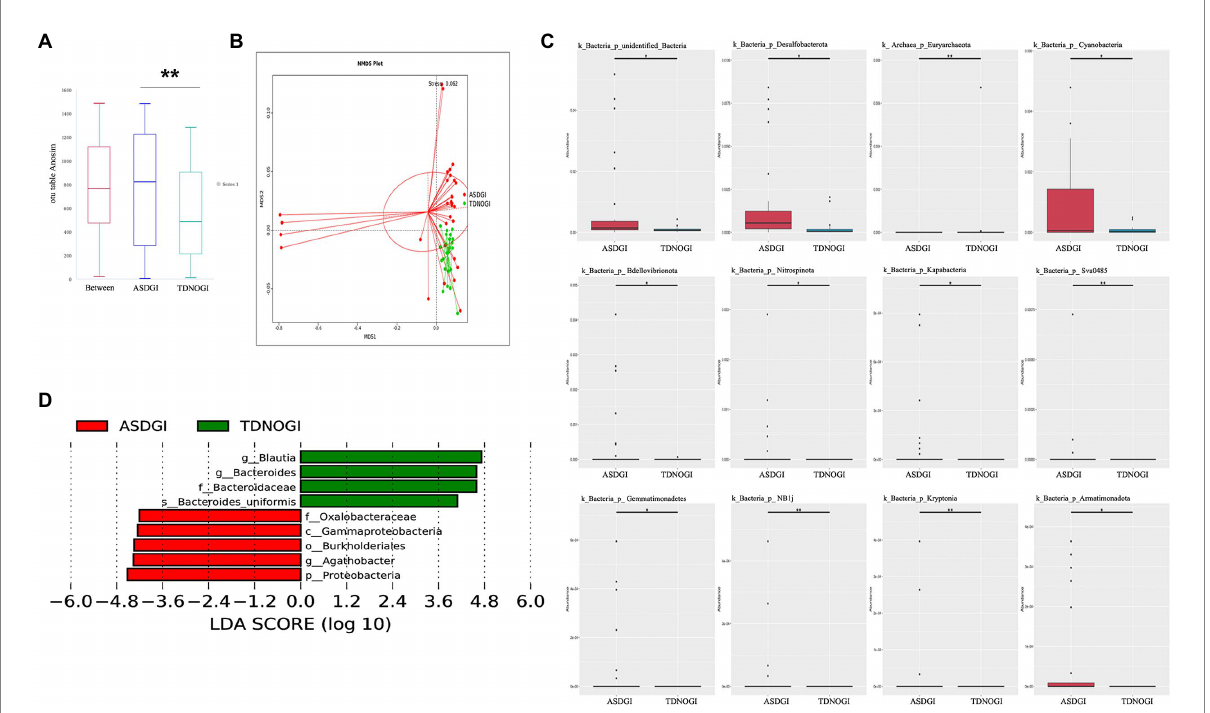
FIGURE 5 The shape of the microbiota with and without GI symptoms. (A) ANOSIM was used to compare within- and between-group similarities ( p = 0.005). (B) Non-metric multidimensional scaling (NMDS) reflected the dramatic variation between the two groups (stress = 0.062). (C) The top 12 relative abundances of the most differentially abundant gut bacterial phyla between ASDGI and TDNOGI. (D) Distribution histogram of phylum level based on linear discriminant analysis (LDA = 4). ** p =